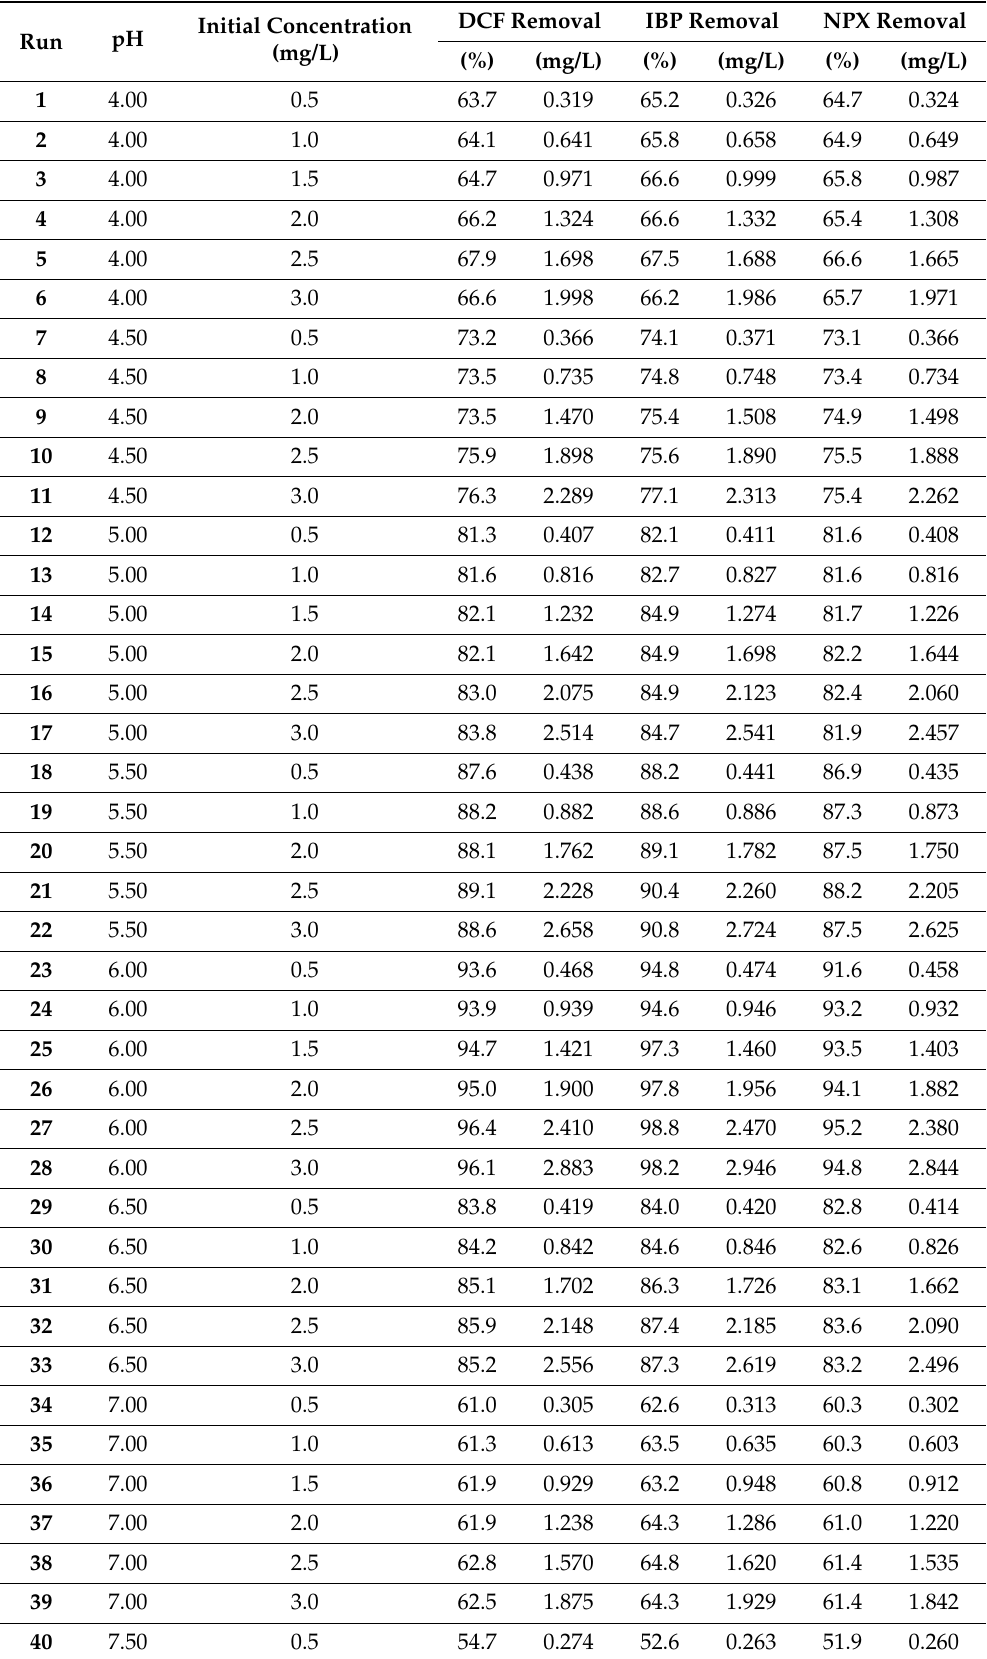
Table 2. Elimination of diclofenac (DCF), ibuprofen (IBP), and naproxen (NPX) by